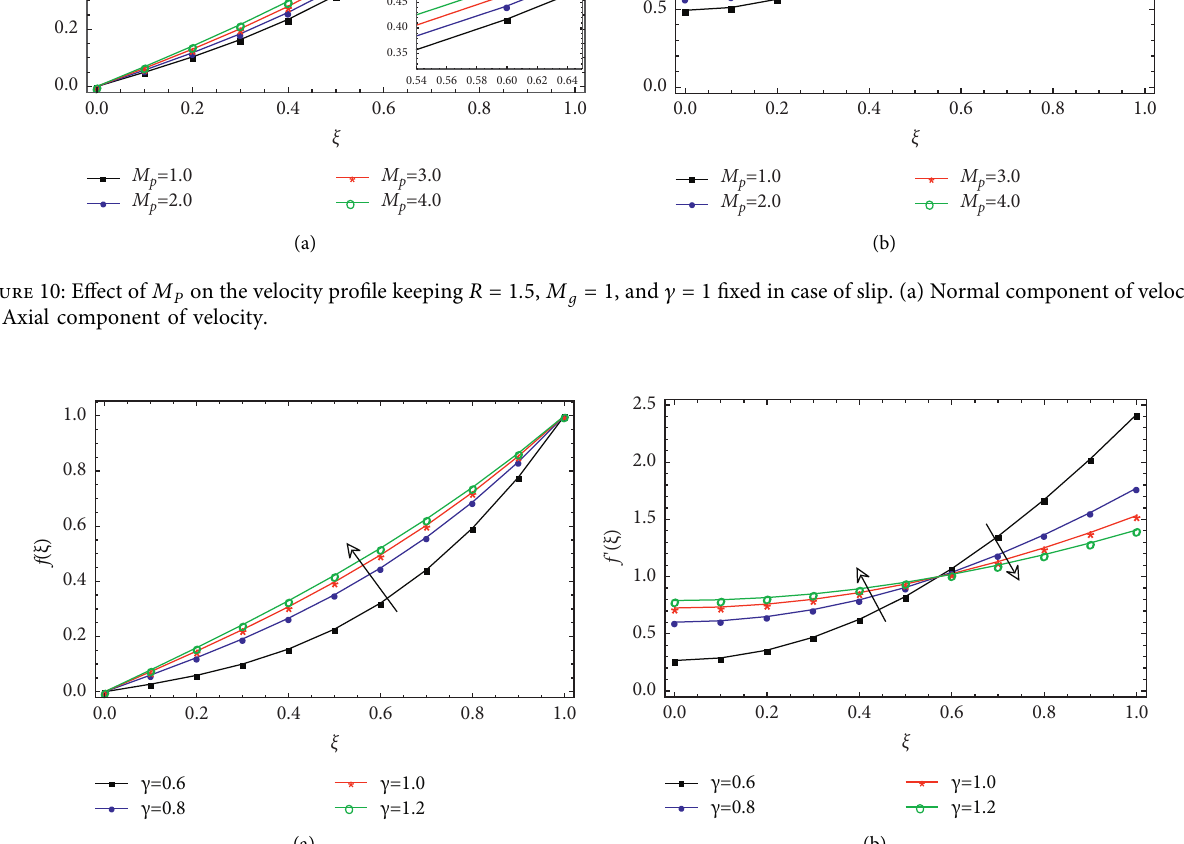
� 1, and M � 0 . 5 fixed in case of slip. (a) Normal component of velocity. g p